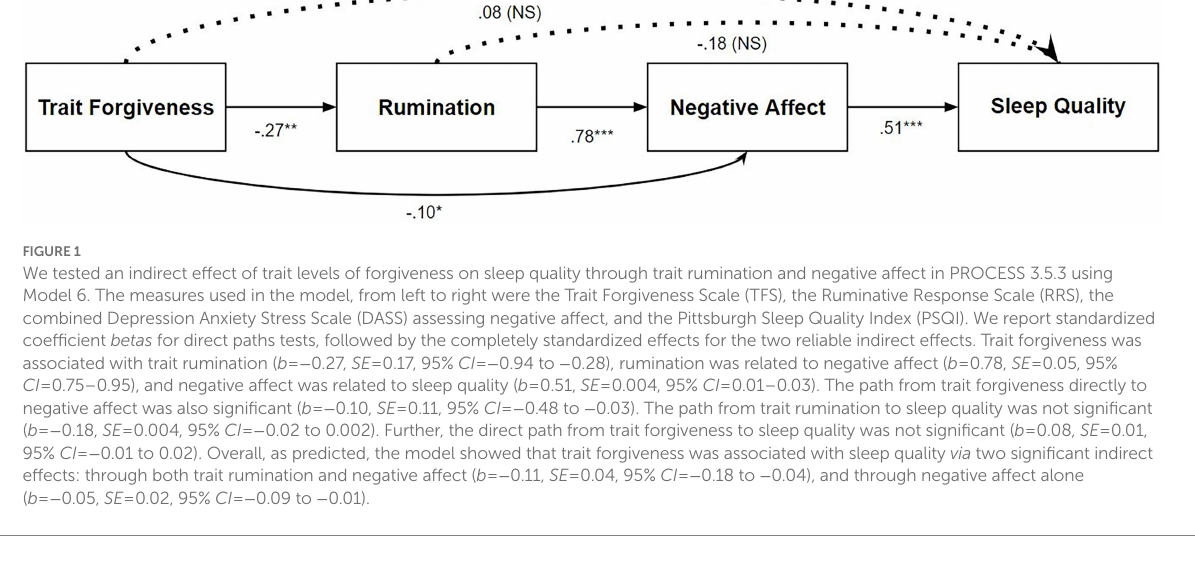
TABLE 2 Night measurement means, standard deviations, F values, 0.95 confidence intervals for condition mean differences, significance, and partial eta-squared effect